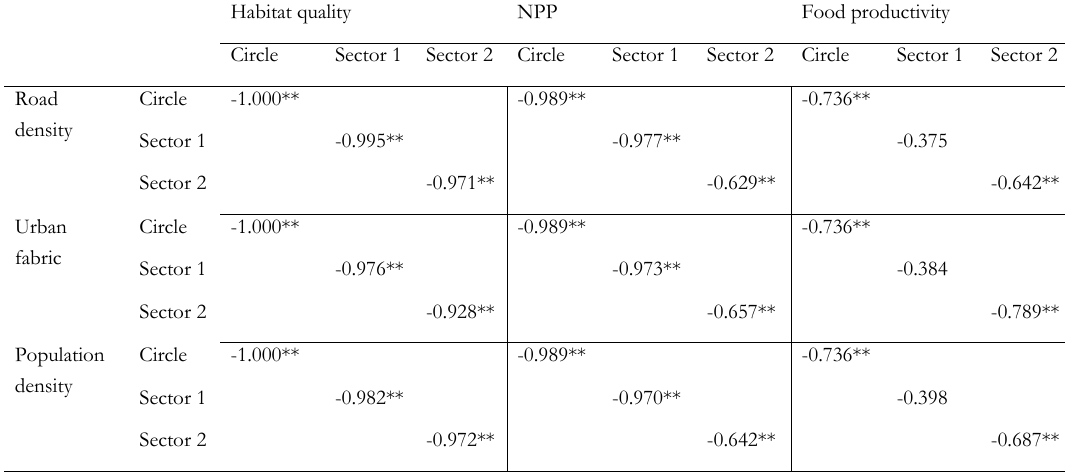
Table 3: Spearman correlations between the ecosystem services and socioeconomic gradients of the circle and sector areas in Kunming urban-rural area. The sample values are the mean values of the indicators in the associated rings. The sample sizes are 15 for the circle area and 20 for the sectors (15 concentric rings in the circle area and 20 concentric sector rings in both of the two sectors). ** P < 0.01, * P <0.05